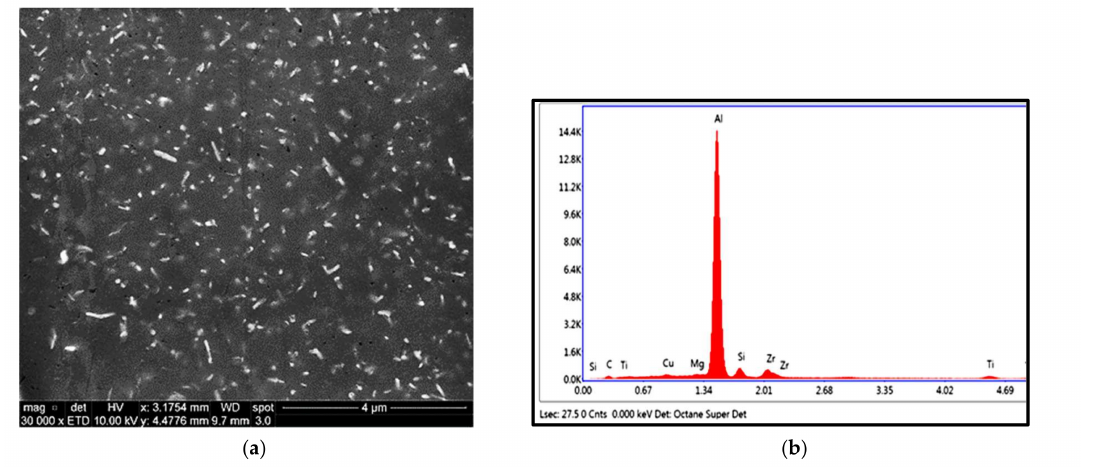
Figure 9. Backscattered electron image showing ( a ) bright, coarse, and fine dispersoids in T6-treated M2S alloy after stabilization at 250 ◦ C for 200 h and testing at the same temperature; ( b ) EDS spectrum of bright particles in ( a ).